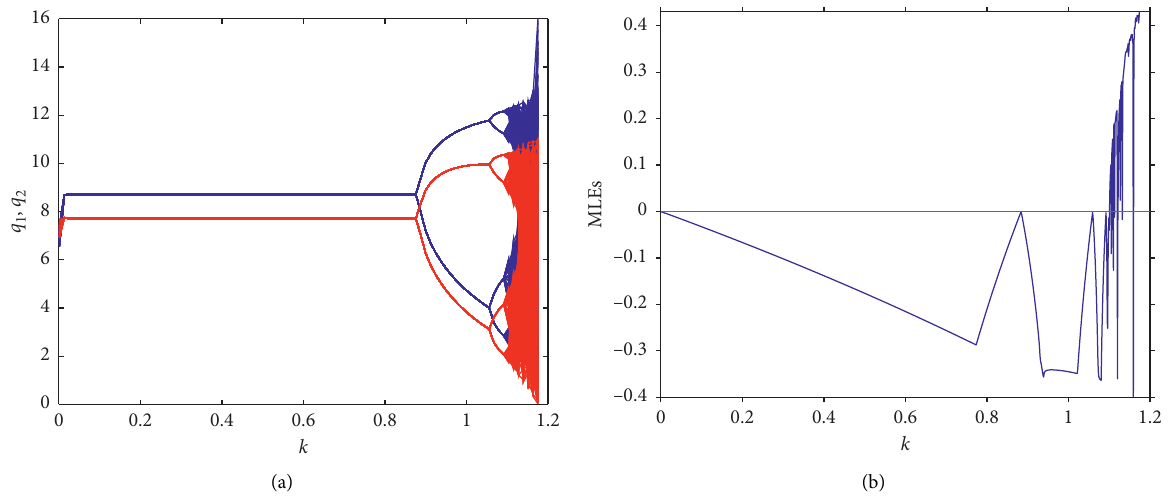
Figure 5: Bifurcation diagram and MLEs for game (12) as a function of k at a � 6 , b � 0 . 3 , c